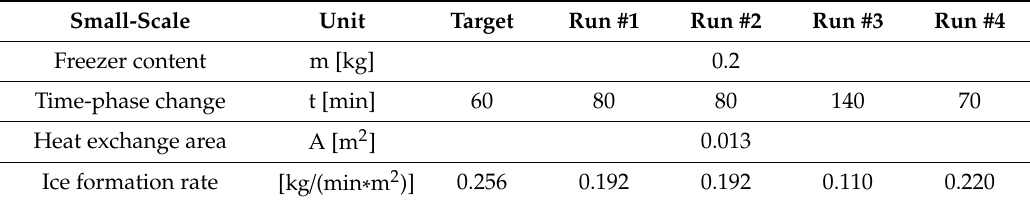
Table 2. Ice formation rate is calculated using obtained times of phase change by the “last point of freeze”, which determines time of phase change.